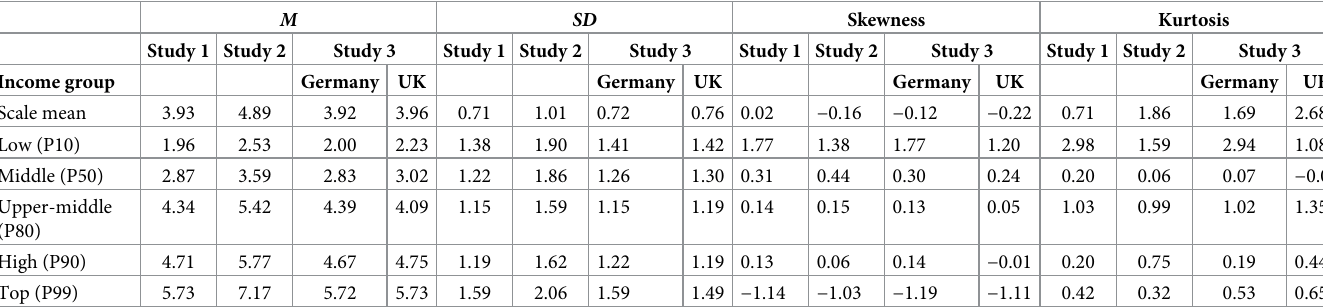
Table 3. Descriptive statistics by study for the JEID